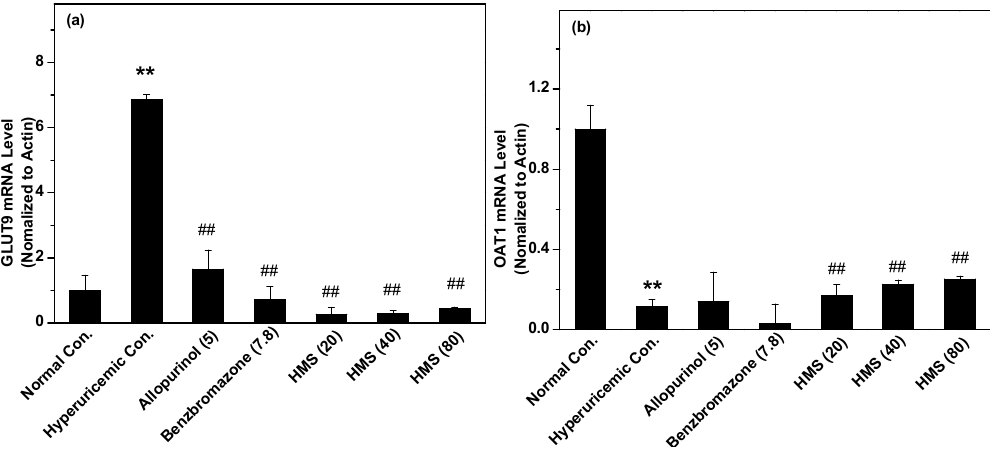
Figure 7. RNA expression levels of GLUT9 ( a ) and OAT1 ( b ). Data were expressed as mean ± SD; n = 3. Statistical analysis by one-way ANOVA followed by two-tailed Student’s t -test; ** p < 0.01 versus the normal control; ## p < 0.01 versus hyperuricemic control.